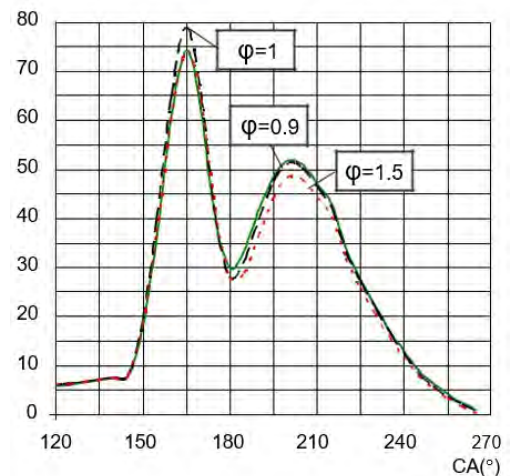
Figure 4. RORH vs crank angle with different equivalenceratios (D15, n=2400rpm)